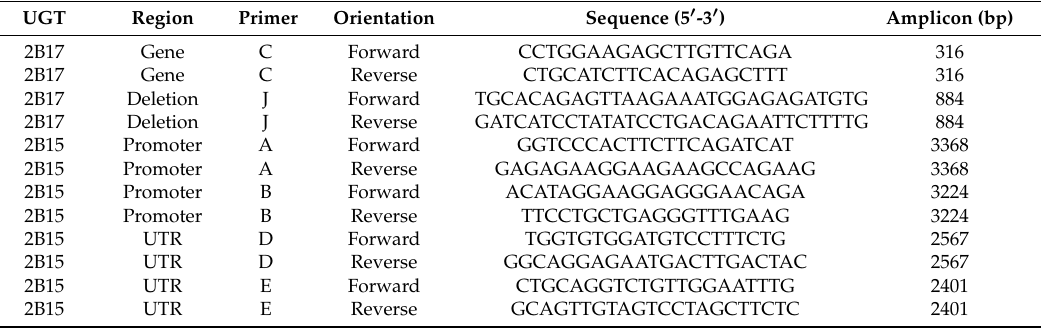
Table 2. Primer sequences for PCR reactions to characterize single nucleotide polymorphisms (SNPs) and deletions. The UGT isoform being examined, region of amplification, primer name, direction, and sequence as well as the resulting amplicon size are shown. UTR: untranslated region.